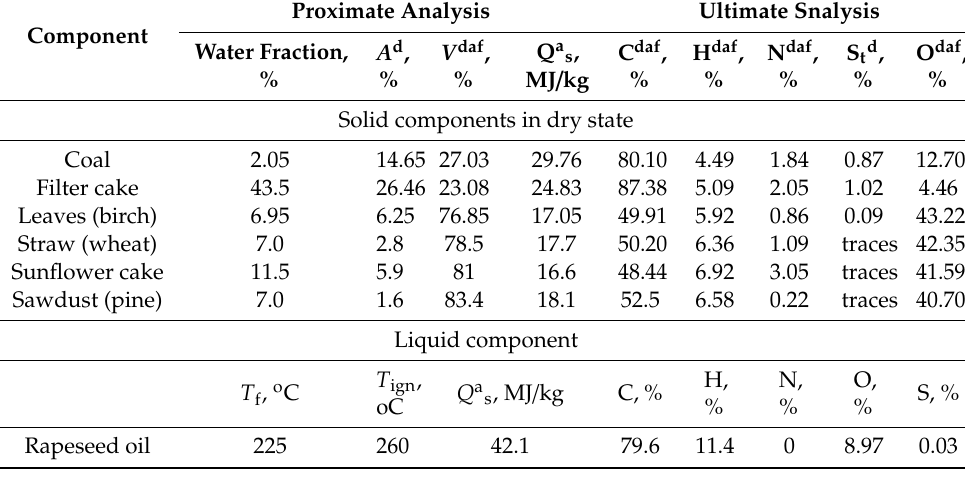
Table 2. Typical properties of fuel slurry components.